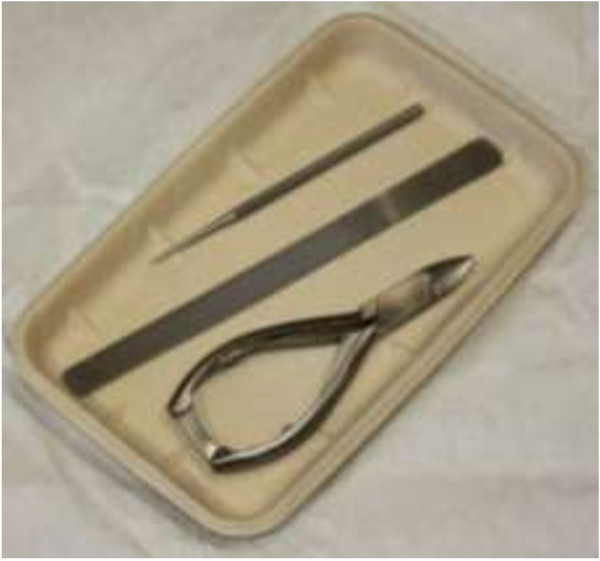
Disposable podiatry instruments.